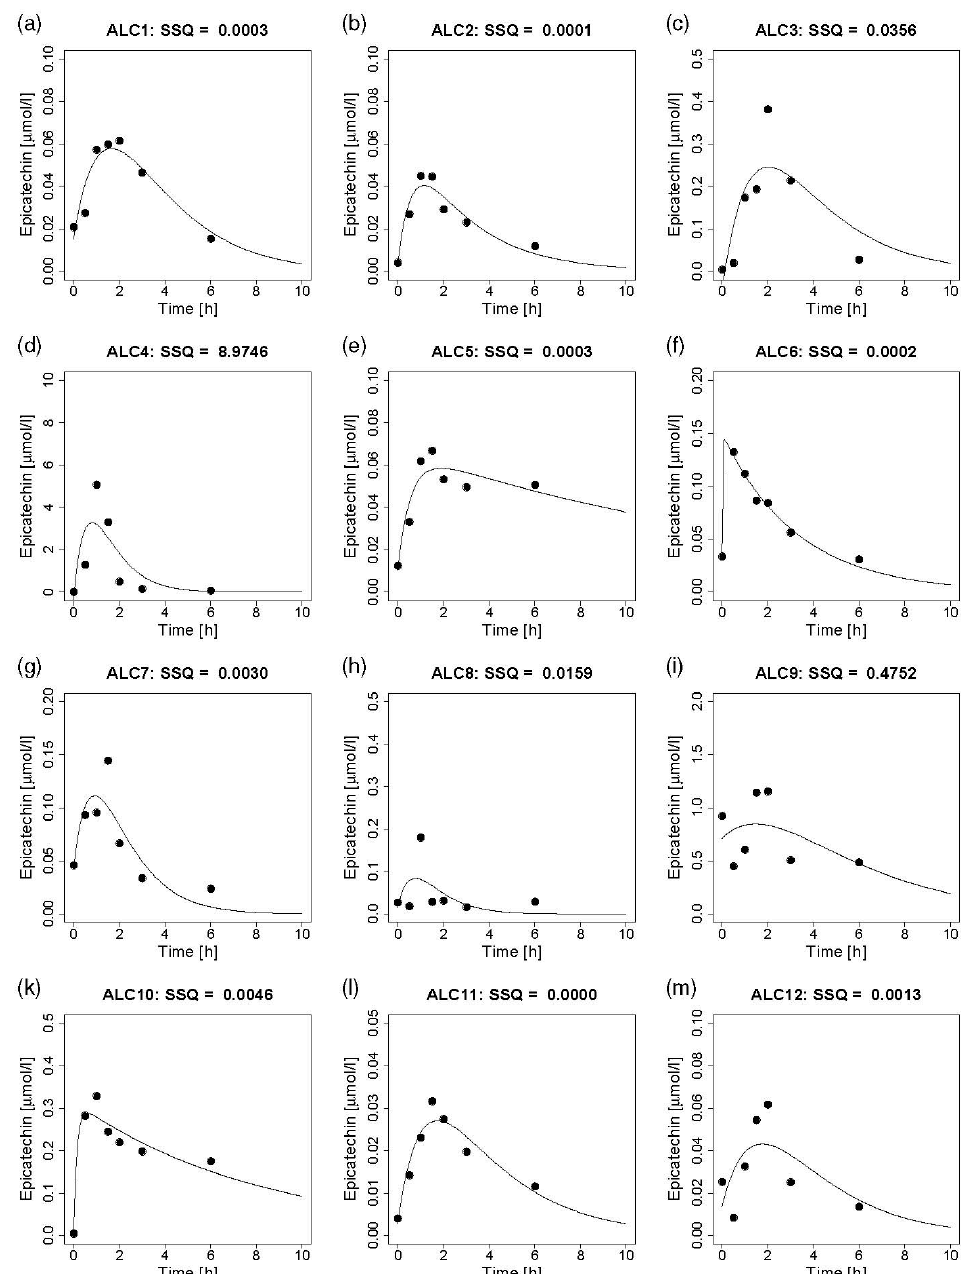
Figure 1. Individual epicatechin concentration time curves obtained after consumption of a beverage prepared with nonalkalized cocoa. Each panel ( a – m ) represents one participant. The dots represent the measured values. The curves reflect the predicted concentrations in plasma within 10 h after in- t 1 / 2a , V hyp / F abs , and Cl were comparable between NALC and ALC, except for t 1 / 2e (Table 4). For t max , gestion of nonalkalized cocoa, based on the one-compartment model. NALC, nonalkalized cocoa; arithmetic means were also comparable, considering a di ff erence between NALC and ALC values of SSQ, sum of squares of residuals. Note the different scaling of the y-axes. 0.64 and the 95% RI ( − 0.67, 1.96).